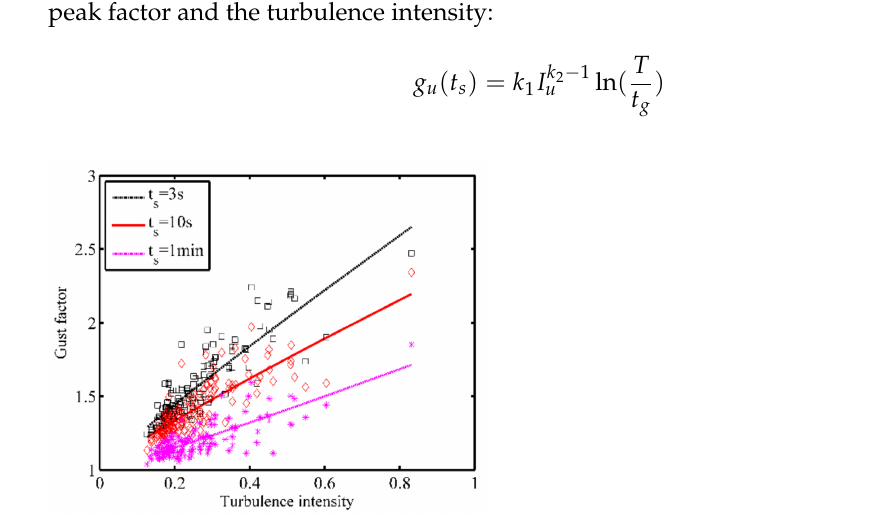
Figure 20. Relationship between the turbulence intensity and the gust factor at different time